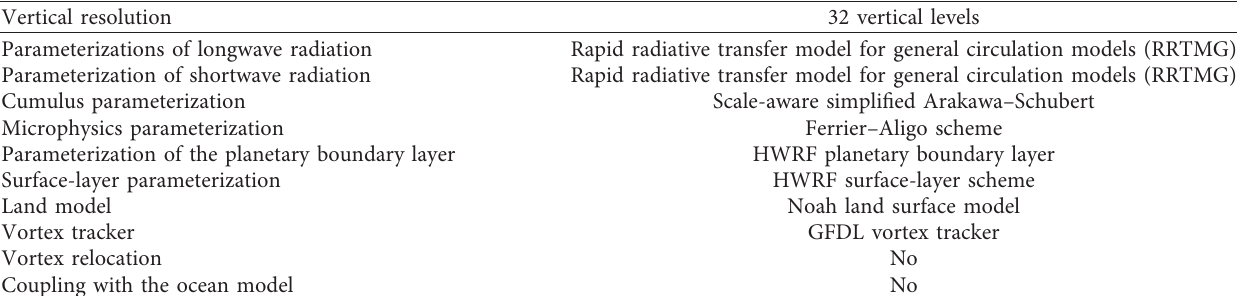
Figure 2: Study area and study cases. (a) Movable nested domains used in the implementation. The inner domain D2 moves with the storm. (b) Cyclones used for evaluation. Circles represent the predicted track, whereas stars represent real trajectories. Most of the selected cyclones developed in the Caribbean Sea and the Gulf of Mexico. Table 1: Configuration used in the model.